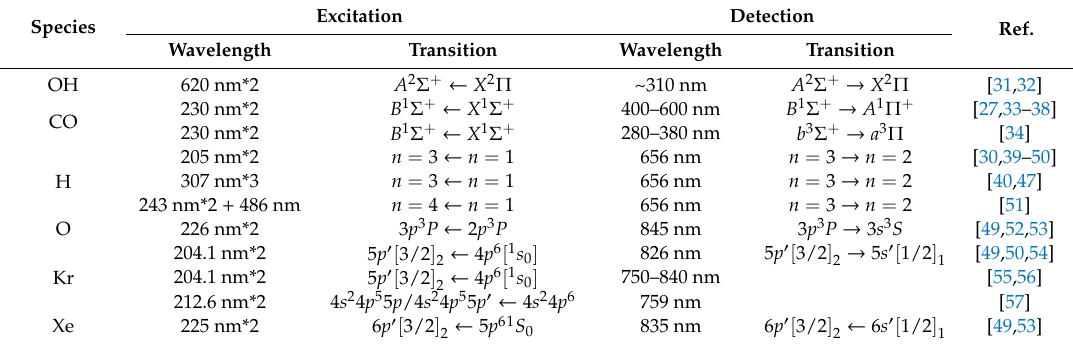
Table 1. Excitation and detection strategies of various species by multi-photo femtosecond laser induced